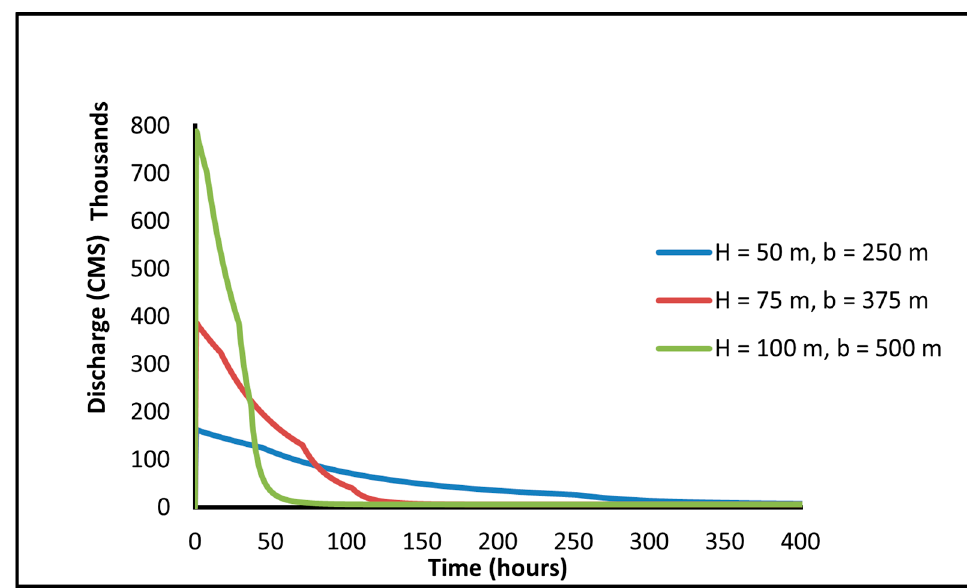
Figure 5. Flood hydrographs due to changes in the breach size.